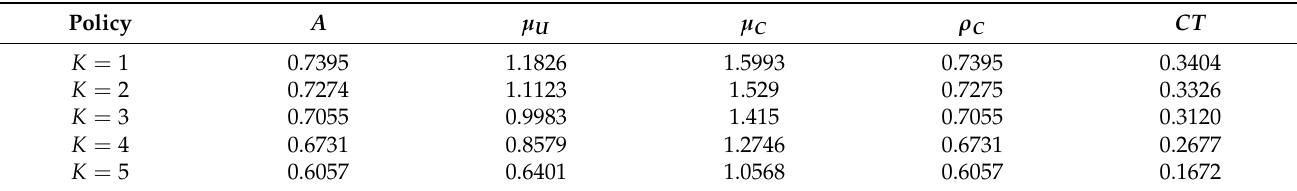
Table 3. Performance measure and the long-run cost rate for systems K = 1,2,3,4,5.